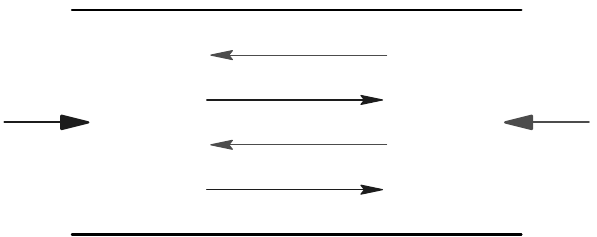
Figure 2 Lane formation in counterflow in a narrow